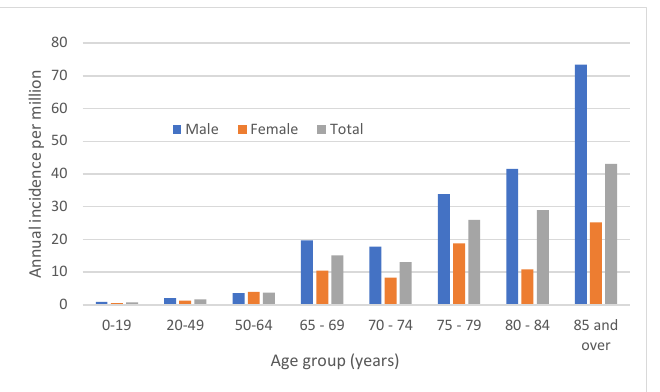
Figure 4. Aeromonas species bloodstream infection incidence per million population by urbanicity in Queensland.